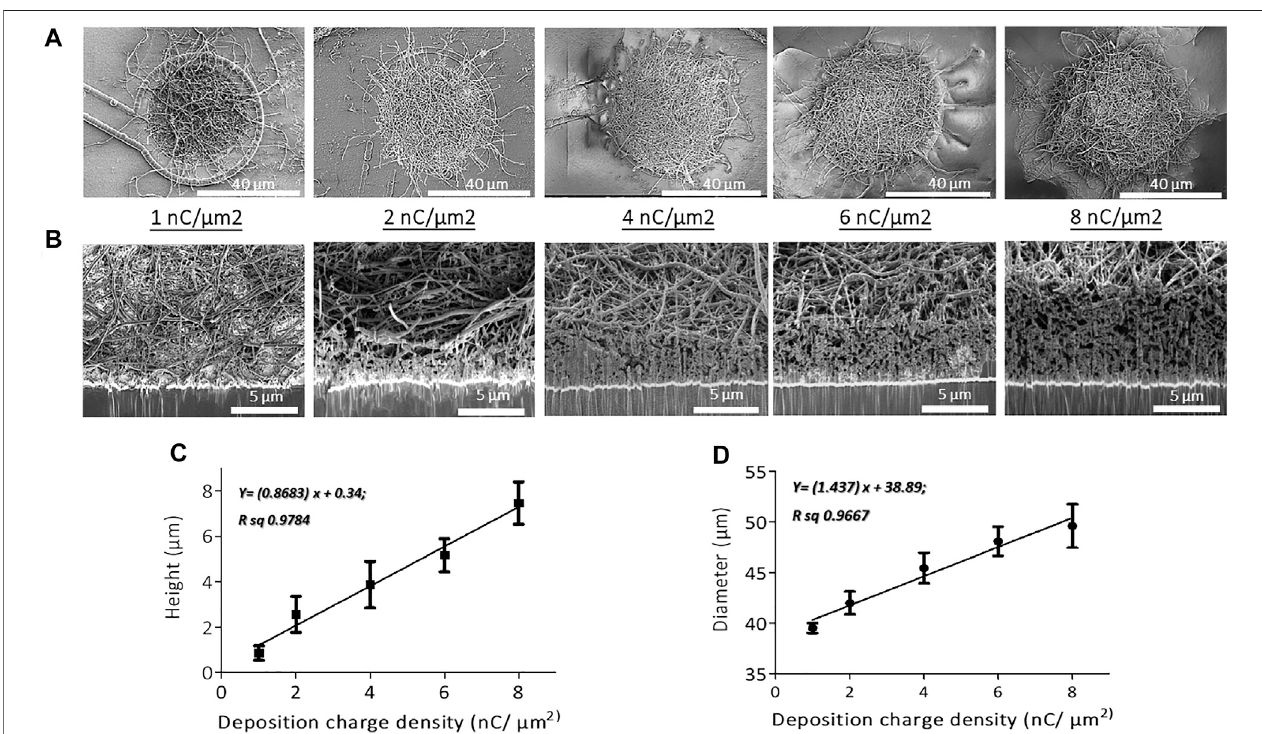
FIGURE 2 | SEM micrographs of (A) top views and (B) cross-sectional views of PEDOT-CNF composites on fl exible gold electrodes with different surface charge densities ranging from 1 to 8 nC/µm 2 . PEDOT-CNF fi lms were galvanostatically deposited on gold microelectrodes with a constant current density of 10 pA/ μ m 2 , using two-electrode con fi guration. Plots describing the evolution of deposition height (C) and diameter (D) of the composite versus deposition charge density. The error bars represent the standard deviation where n (cid:2)